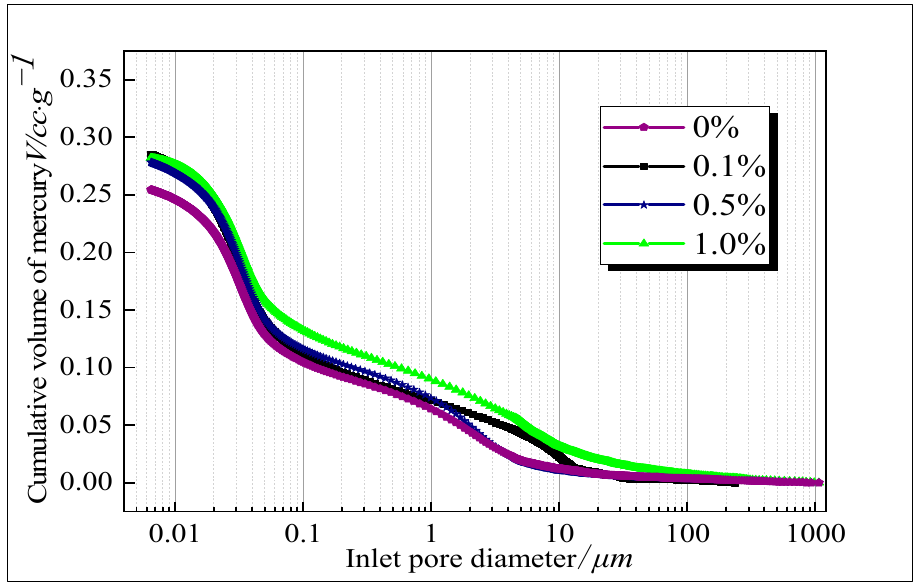
Figure 2. Pore size–cumulative mercury input relationship curve of Guilin red clay under the effect of different concentrations of heavy metal ions.